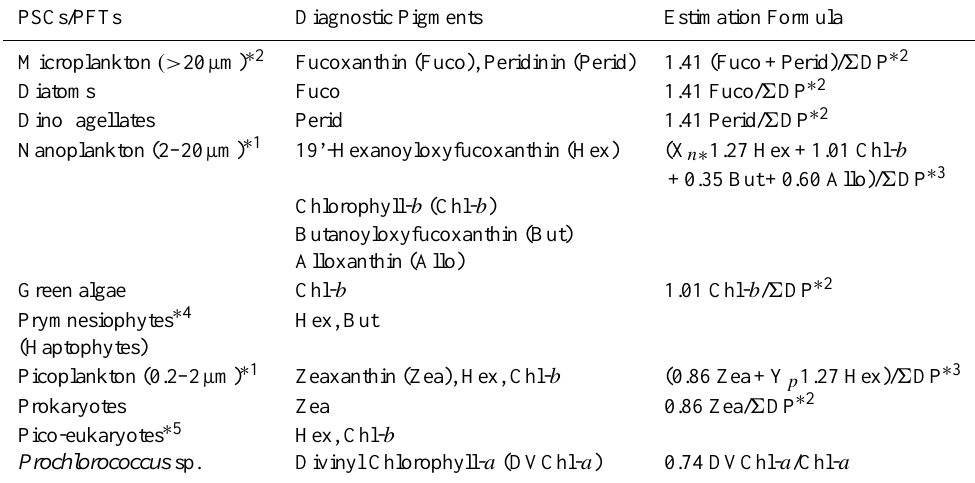
Table 1. Phytoplankton Size Classes (PSCs) and Phytoplankton Functional Types (PFTs) represented by their